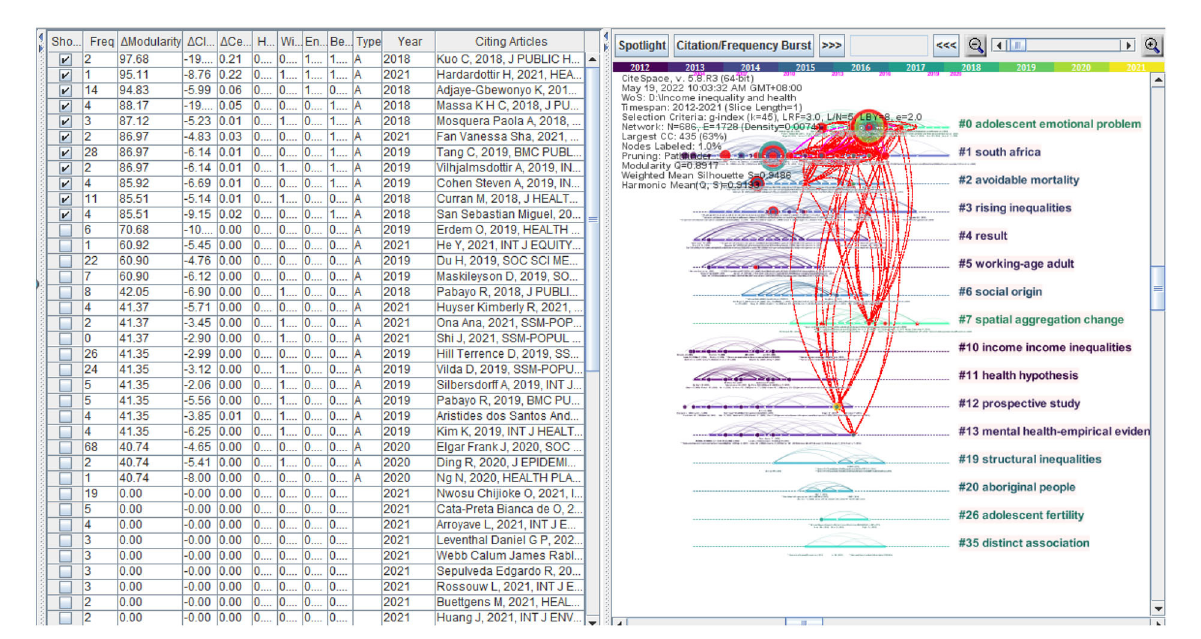
FIGURE11 Timeline visualization of clusters and SVA’s result in